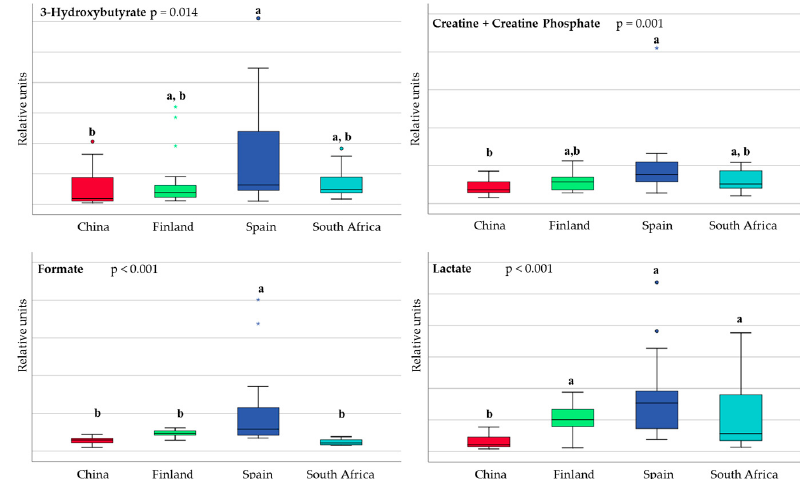
Figure 4. Box and whisker plot showing statistical significant differences in energy metabolites in breast milk in samples from China (red), Finland (green), Spain (blue) and South Africa (pale blue). Data are expressed in relative units. Each bar represents the smallest observation, lower quartile ( Q1 ), median, upper quartile ( Q3 ) and largest observation. Circles and stars indicate outlier data. Differences among countries were calculated using the Kruskal–Wallis test. Unlike letters indicate statistically significant differences among countries.